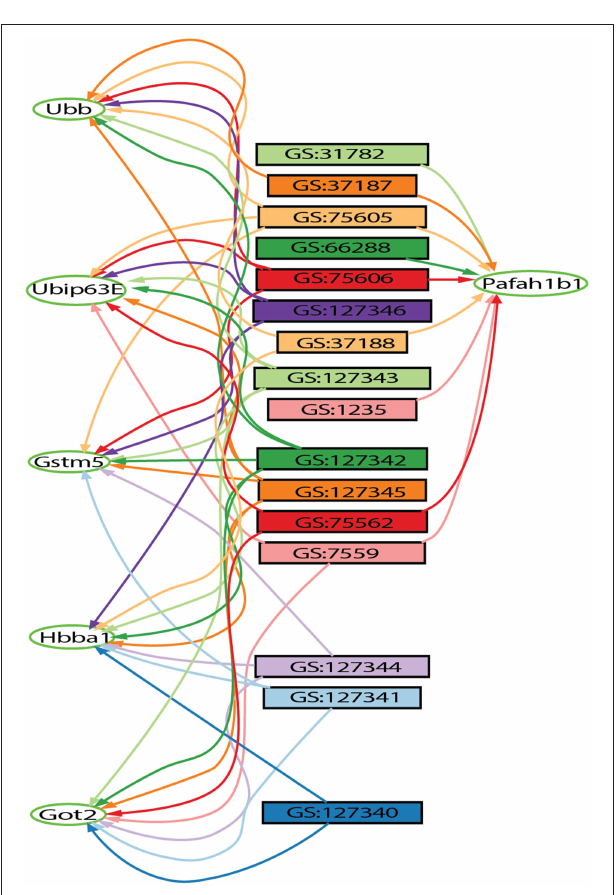
FIGURE 2 | Output from the gene set graph tool showing Pafah1b1 -connected gene sets and other high-degree genes found on these sets. The genes are represented by oval shaped nodes, edges represent gene set membership, and the rectangular nodes represent gene sets retrieved from the GeneWeaver database. Other highly connected genes include Gstm5, Ubb, Hbaa1, Got2, and Ubi-p63E .